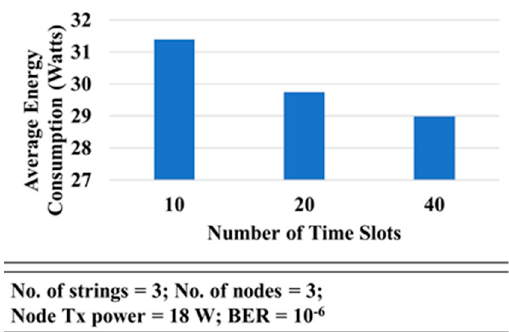
Figure 19. Comparison of Time Slots for Collision Rate and Convergence Delay. Sensors 2018 , 18 , 4178